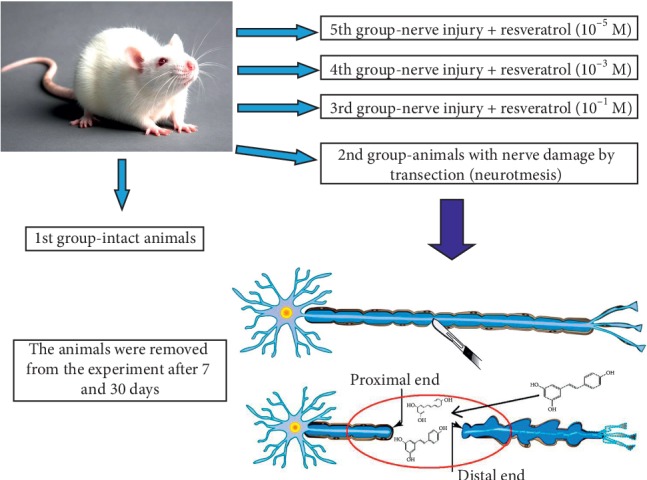
Experiment design.